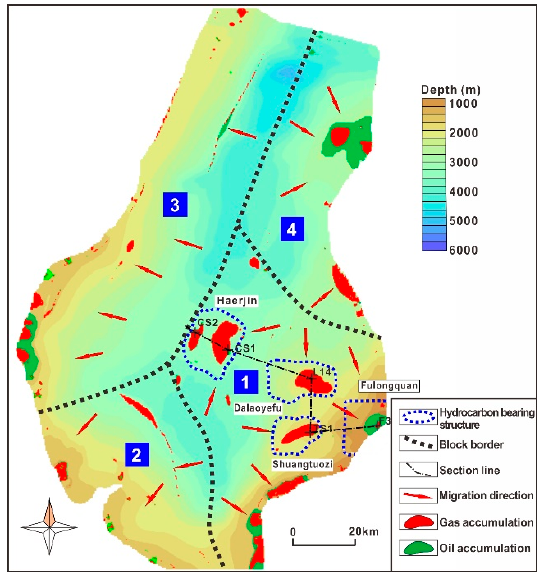
Figure 17. Migration and accumulation units of the Changling Depression: 1. central uplift zone, 2. southern fault sag zone, 3. western slope zone, 4. northeastern slope zone.